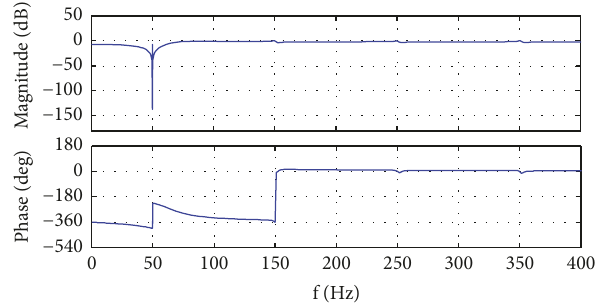
Figure 9: The bode diagram of 𝑋 ℎ (𝑠) .